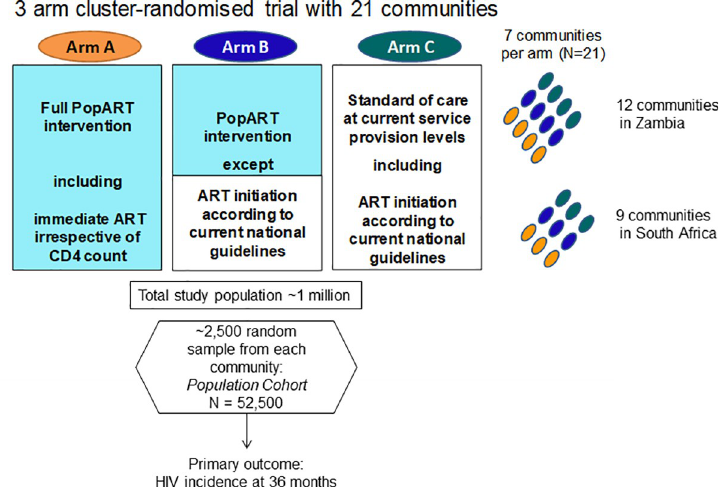
Fig 1. Summary of the HPTN 071 (PopART) trial design. CD4, cluster of differentiation 4; ART, antiretroviral